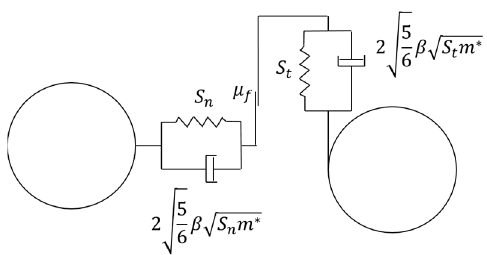
Figure 2. Hertz–Mindlin spring and dashpot system. The particle interaction force is split into the normal and tangential components, where normal is defined at the point of contact between particles.